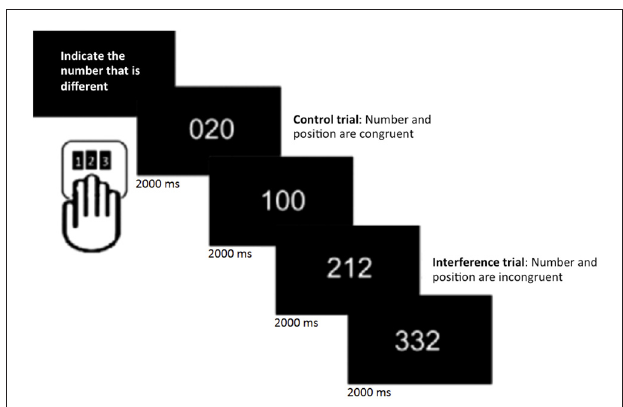
FIGURE 1 | Multi-Source Interference task (MSIT; Bush et al., 2003). In each trial, participants were asked to indicate the number that was different by pressing the spatially corresponding key on the button